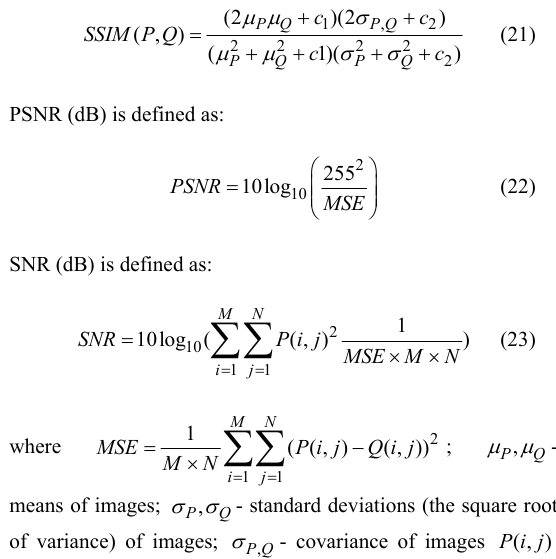
Figure 1. Original image (a); Racian noise image (b) with 10  ; denoising results with TV (c), BLS- GSM (d), FBF (e), ADF (f), WF (g) , L=2 (h), L=3